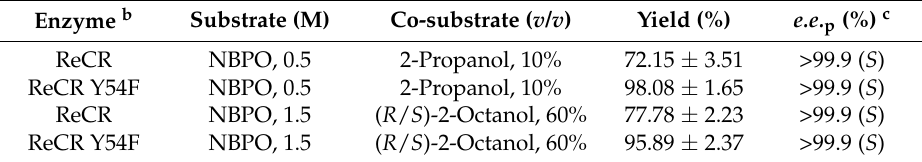
Table 4. Asymmetric reduction of N -Boc-3-piperidone catalyzed by whole cells overexpressing ReCR or ReCR Y54F a